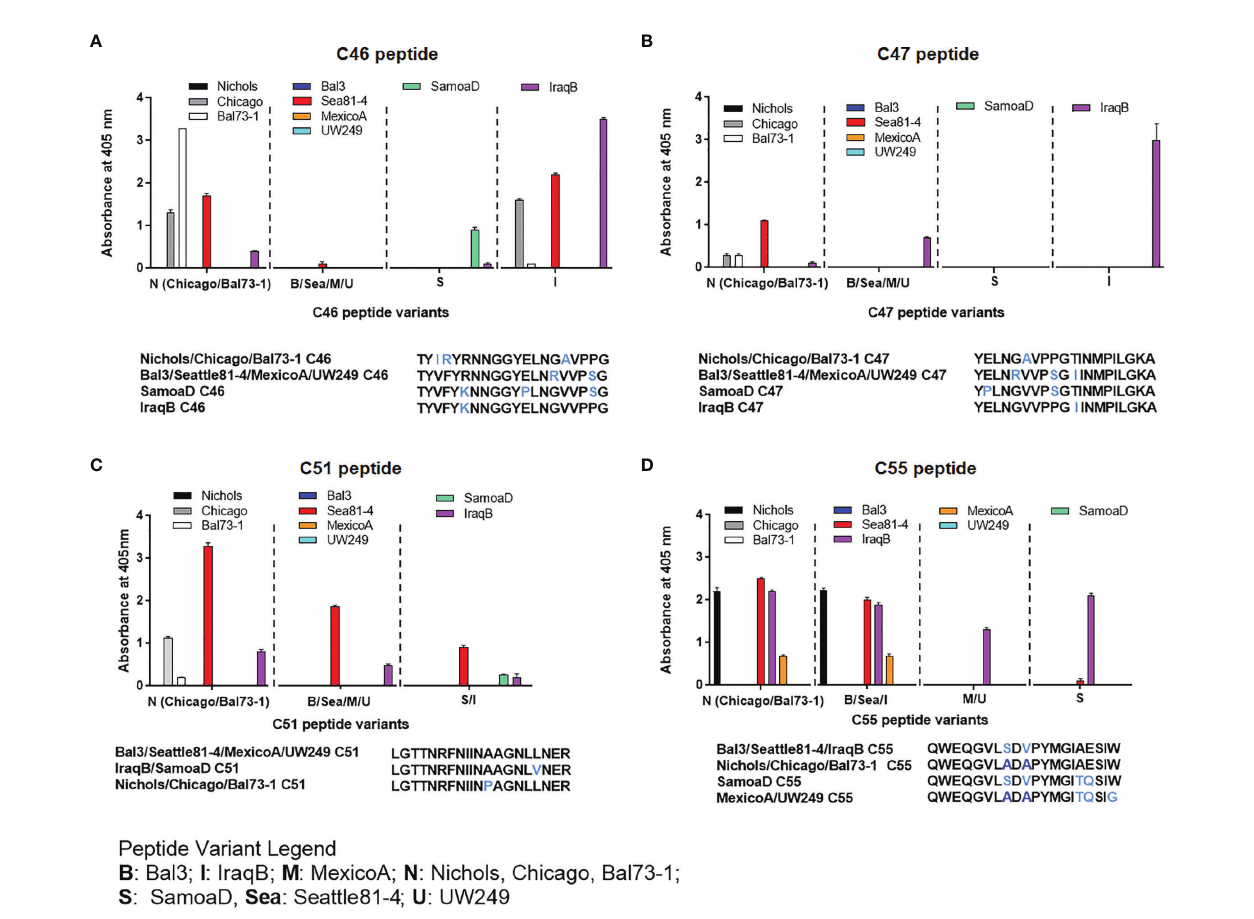
FIGURE 4 | Reactivity of sera from experimentally infected animals to homologous and non-homologous peptides C46, C47, C51, and C55. Humoral reactivity of day-90 sera from experimentally infected animals to homologous and non-homologous TprC peptides. (A-D) reactivity to C46, C47, C51, and C55 variants. Strain names on x axes are abbreviated as follows: N, Nichols; M, MexicoA; Sea, Sea81-4; B, Bal3; U, UW249; S, SamoaD; I,